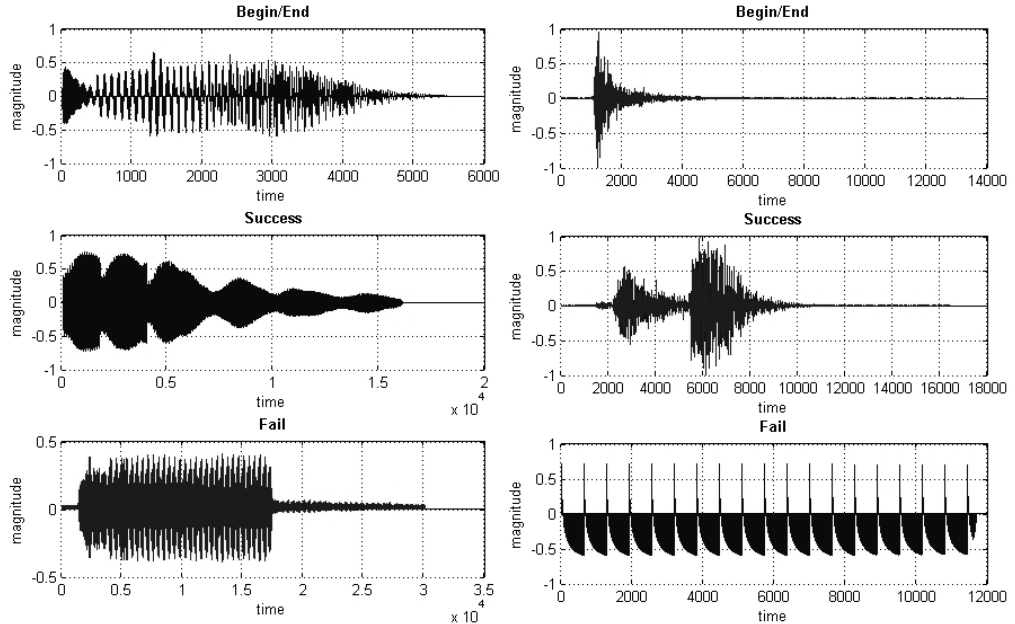
Figure 17. Three signals for the aural feedback ( Left ) and haptic feedback ( Right ). The unit of magnitude is